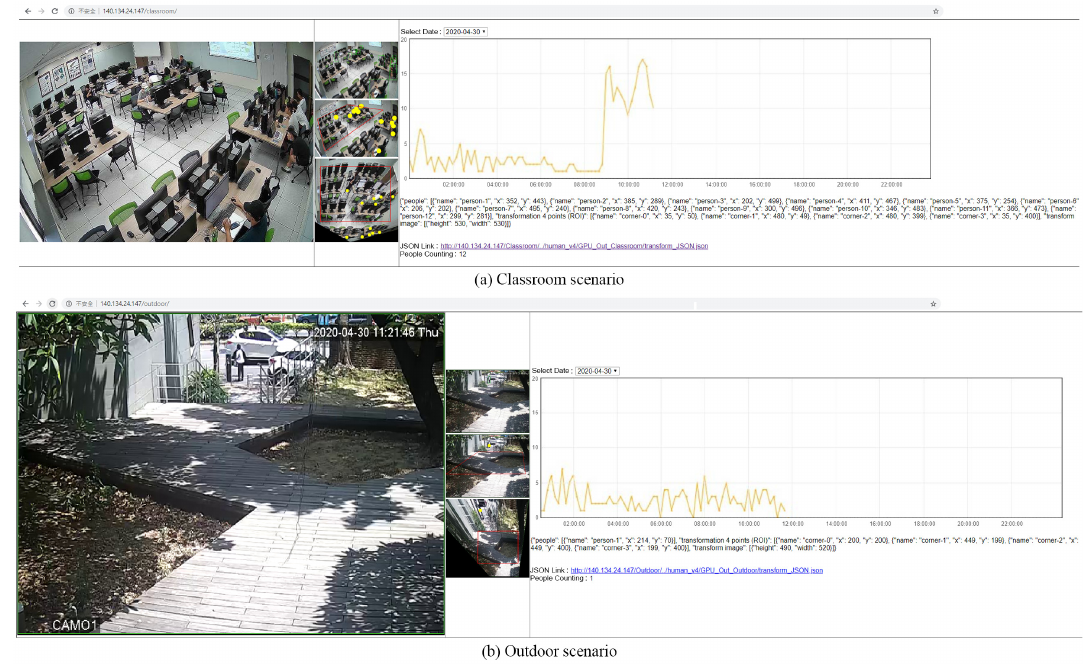
Figure 7. Web-based user